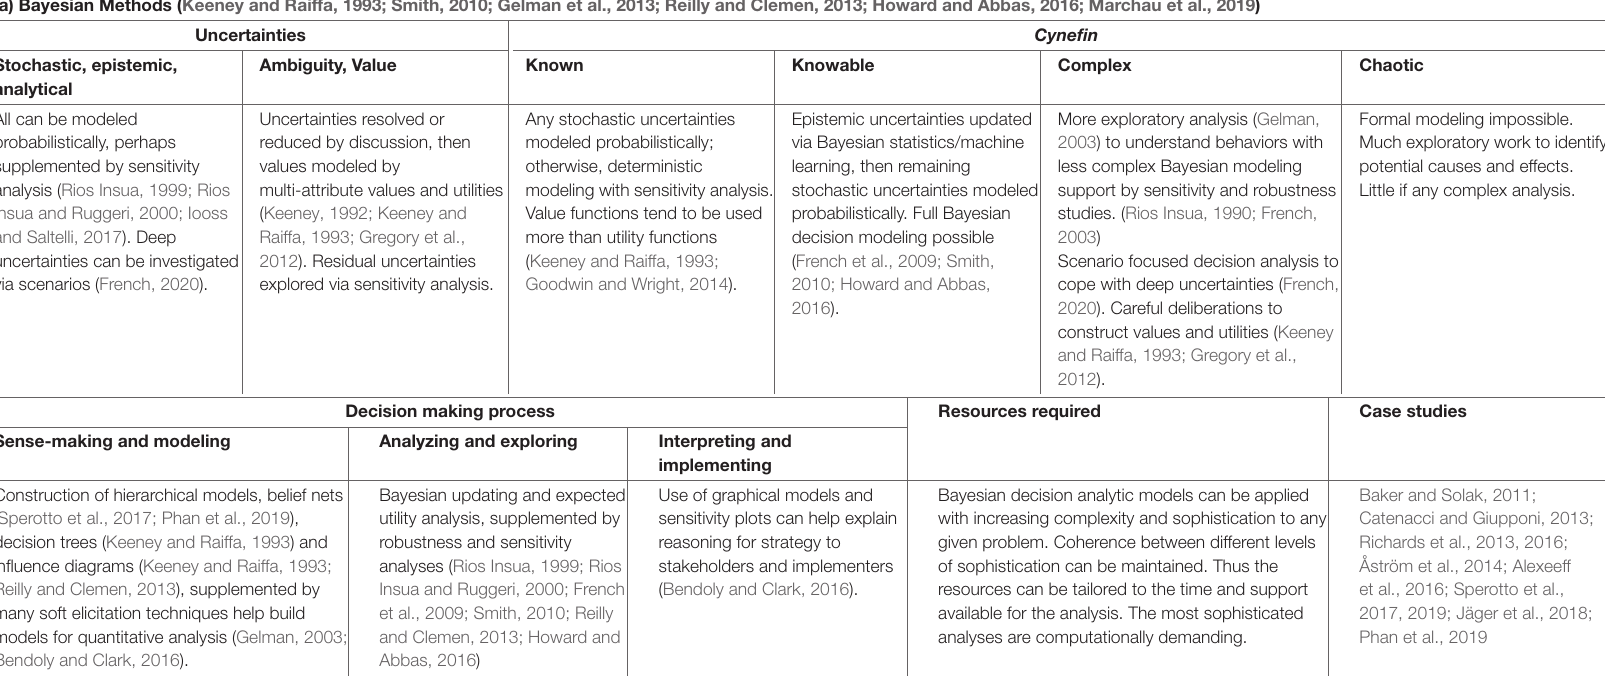
TABLE 3 | Characteristics of the main approaches to decision analysis with respect to their Cynefin context, the manner in which they can be used to address different uncertainties, where they may be used in different phases of the decision-making process, the resources required, and some case studies for further exploring how they might be used. (a) Bayesian Methods (Keeney and Raiffa, 1993; Smith, 2010; Gelman et al., 2013; Reilly and Clemen, 2013; Howard and Abbas, 2016; Marchau et al., 2019) Uncertainties Cynefin Stochastic, epistemic, Ambiguity, Value Known Knowable Complex analytical